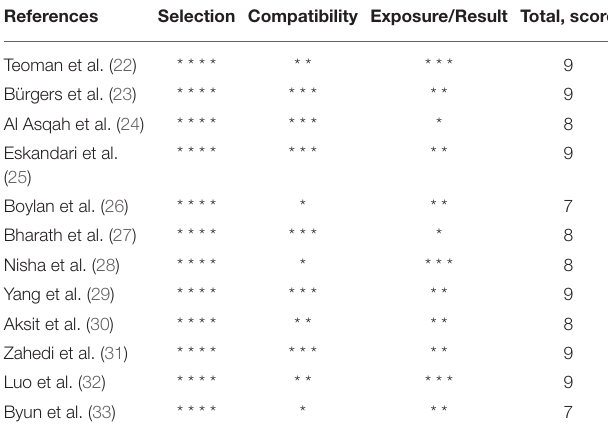
TABLE 3 | Assessment of the quality of included studies using the Newcastle-Ottawa